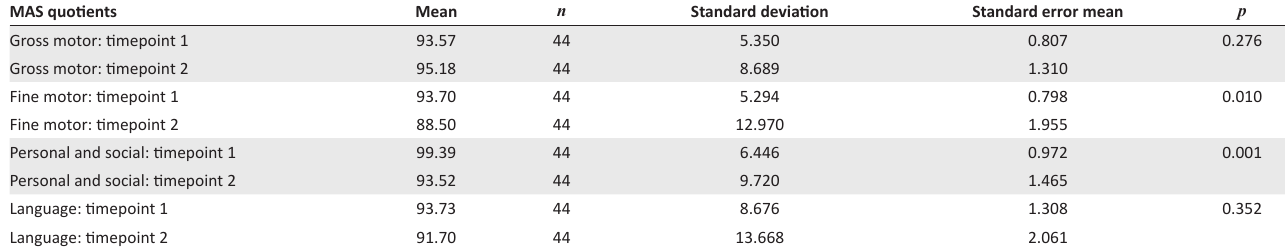
FIG URE 6: Bland–Altman scatter plot illustrating mean difference between Molteno Adapted Scale and Bayley Scales of Infant and Toddler Development- 3rd edition fine motor scores versus Molteno Adapted Scale and Bayley Scales of Infant and Toddler Development-3rd edition fine motor scores at the 2–3-year TABLE 4: Comparison of Molteno Adapted Scale quotients at 11–14 months (timepoint 1) and 30–42 month (timepoint 2). MAS quotients